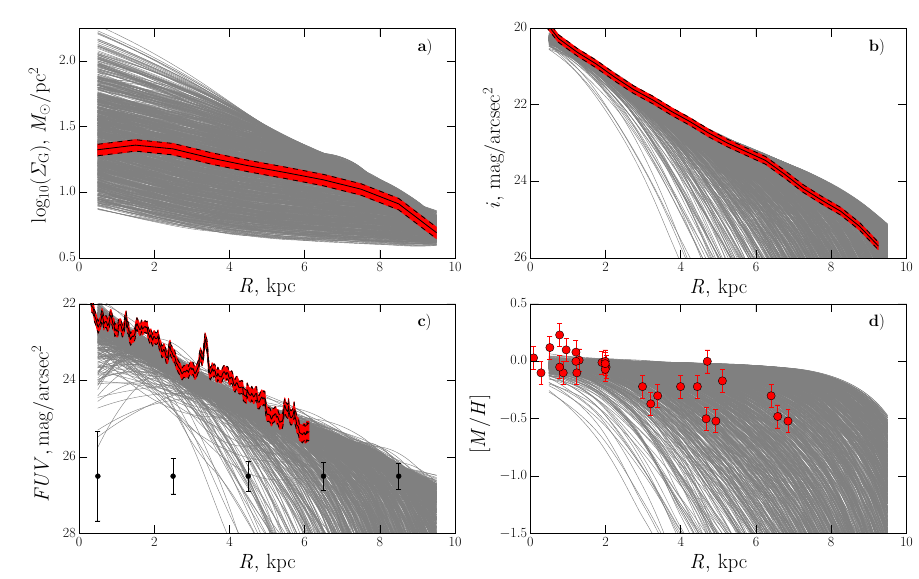
Fig. 2. Comparison of the observational data on the galaxy M33 with the models. The gas surface density (panel a) is computed by co-adding the radial profiles of H I (Corbelli & Salucci 2000) and H 2 (Heyer et al. 2004) gas surface density. The surface brightness radial profile in the i passband (panel b) (Ferguson et. al. 2007) is corrected for internal extinction using the radial extinction profile by Munoz-Mateos et al. (2007) and assuming the LMC-like extinction law (Gordon et al. 2003). The surface brightness radial profile in GALEX FUV passband (panel c) (Munoz-Mateos et al. 2007) is also corrected for internal extinction. The metallicity measurements of blue supergiant stars (panel d) are taken from Urbaneja et al. (2005) and U et al. (2009). All radial profiles of observed surface brightness are de-projected adopting 54 ◦ for the galaxy disk inclination. et al. 2007) passbands, and metallicity (Urbaneja et al. 2005; U et al.